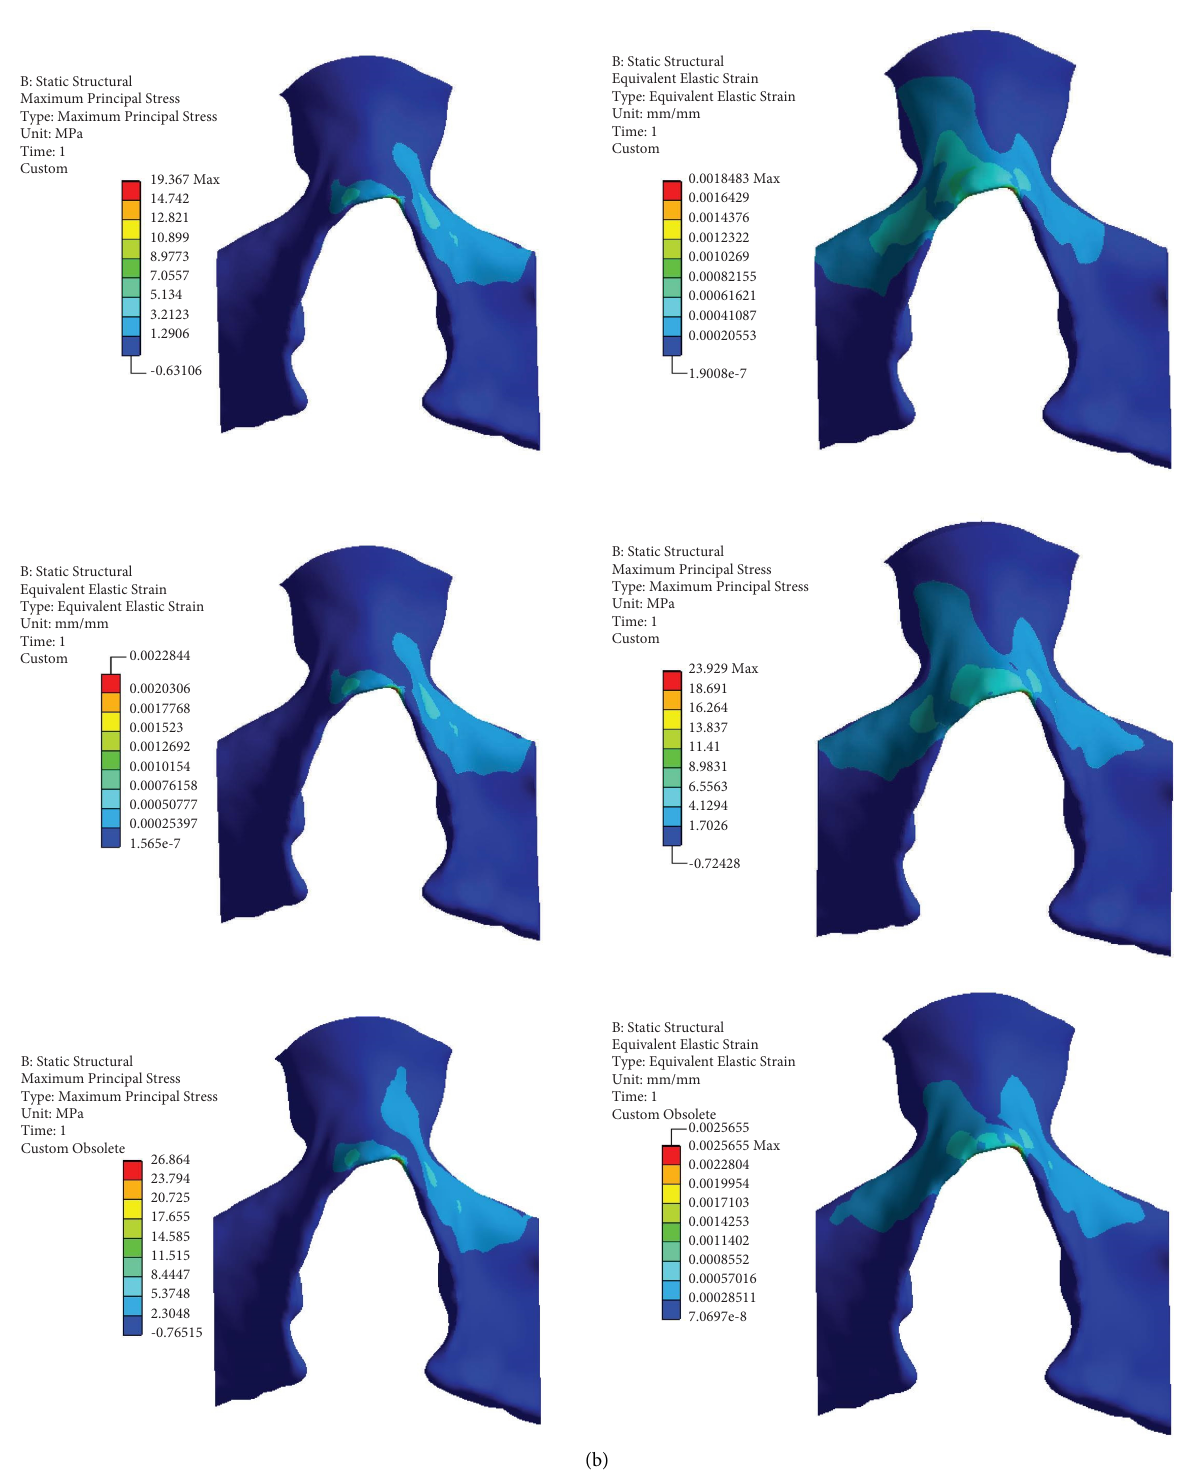
Figure 4: Distribution of stress and strain at the lower end of nasal bone at diferent